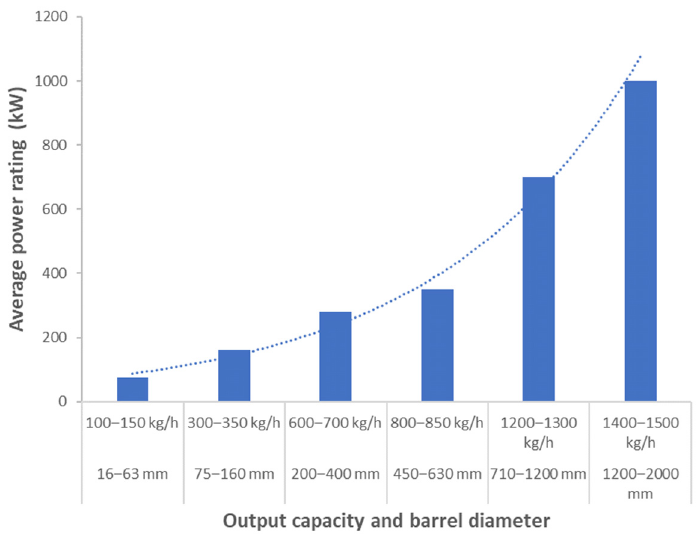
Figure 3. Comparison of single-screw extruders advertised in Alibaba in 2021. Source [130].